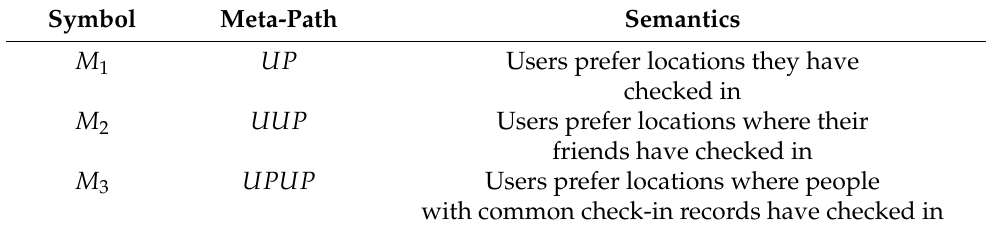
Table 1. Meta-paths and their